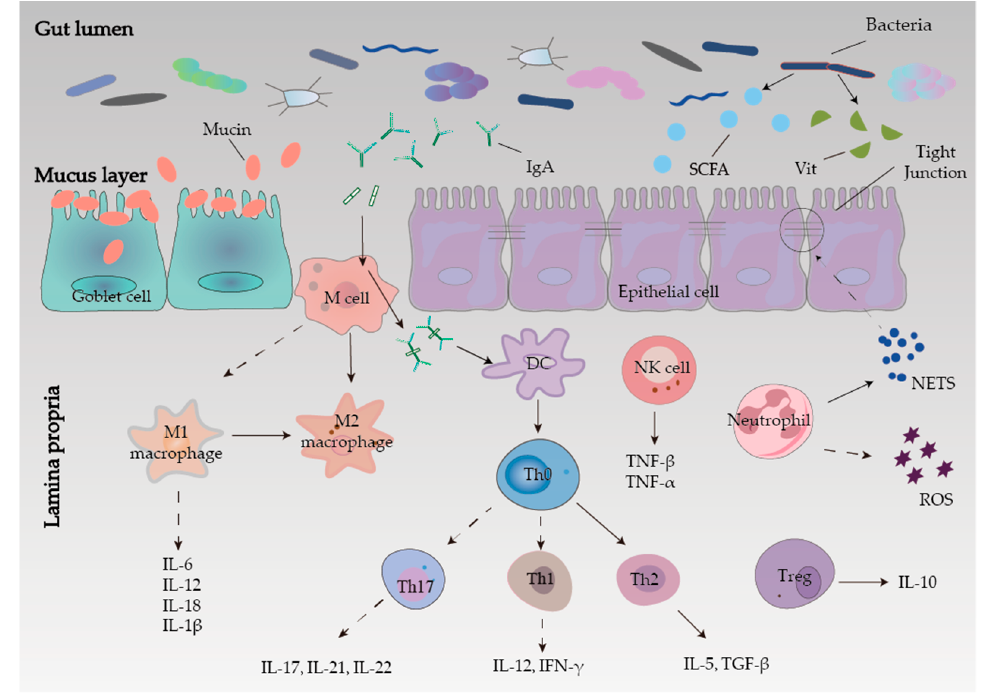
Figure 1. Intestinal mucosal barrier function.